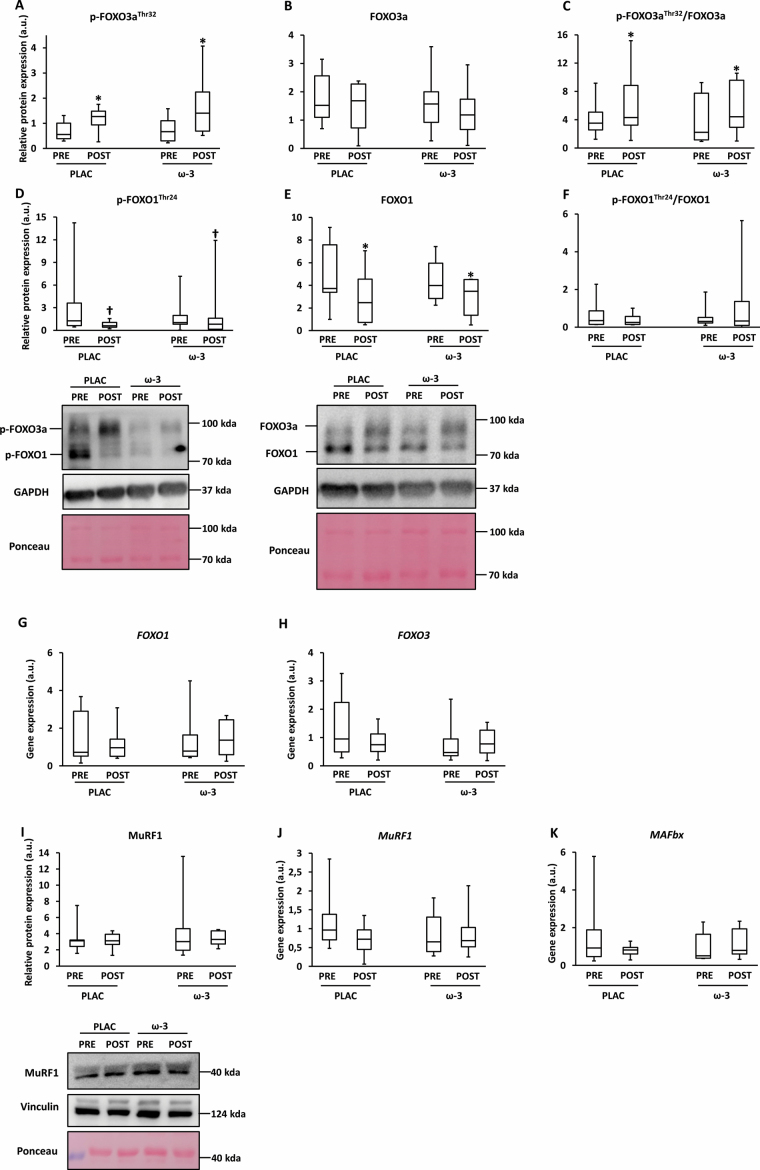
Expression of ubiquitin-proteasome markers in skeletal muscle tissue before (PRE) and after (POST) 12-week resistance exercise in the placebo (PLAC) and omega-3 (ω-3) group. (A) Phosphorylated forkhead box O (FOXO) 3a at the Thr32-site, (B) total FOXO3a, (C) p-FOXO3a/total FOXO3a, (D) p-FOXO1 at the Thr24-site, (E) total FOXO1, (F) p-FOXO1/total FOXO1, (G) FOXO1 gene expression, (H) FOXO3 gene expression, (I) muscle-specific RING finger protein 1 (MuRF1) protein expression, (J) MuRF1 gene expression, (K) muscle atrophy F-box (MAFbx) gene expression. For all boxplots, the box represents the interquartile range, the horizontal line in the box represents the median, and the error bars represent the maximum and minimum values. Data were analyzed with a 2-way repeated measures ANOVA to detect differences over time (PRE vs POST) and between groups (PLAC vs Ω-3). *p < .05 (POST vs PRE); †p = .5–.1 (POST vs PRE).